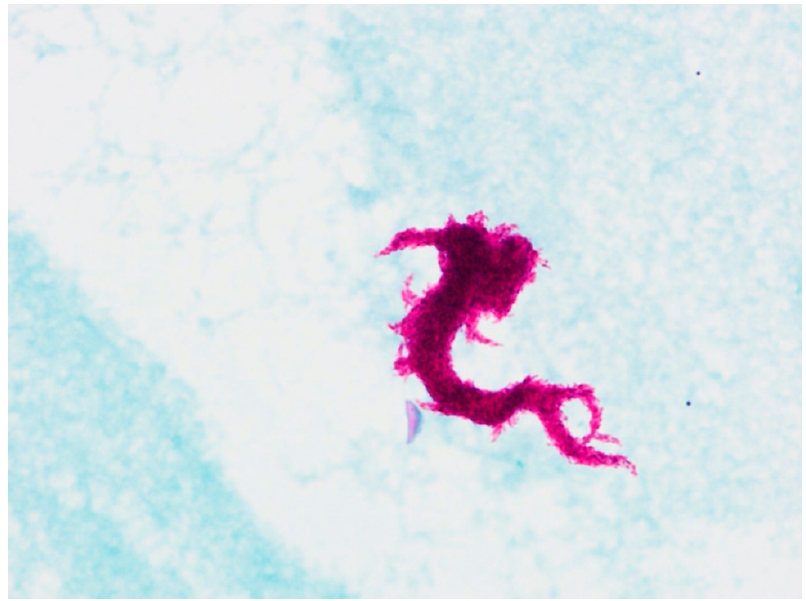
Figure 3. Ziehl-Nielsen-stained slide of mycobacterial cultures obtained on MGIT liquid media with characteristic serpentine cord factor (trehalose 6,6 ′ -dimicolate).